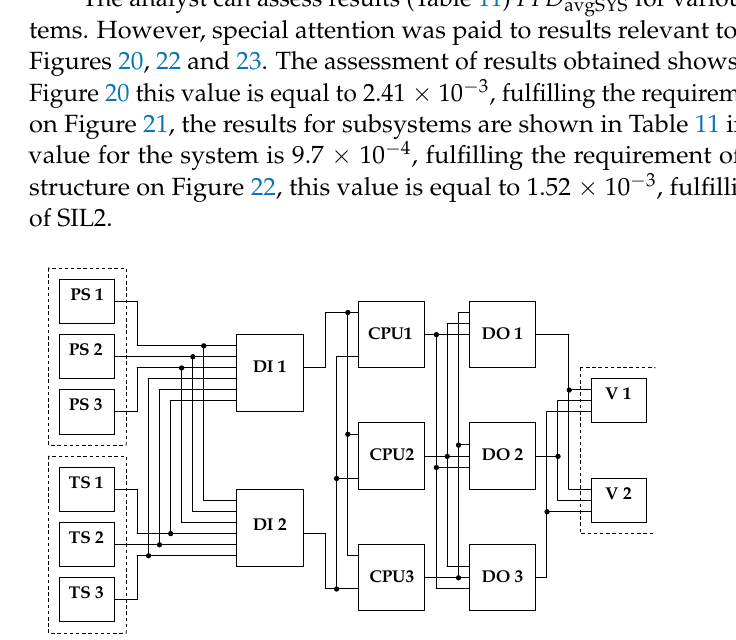
Figure 22. Structure II of E/E/PE safety-related system.